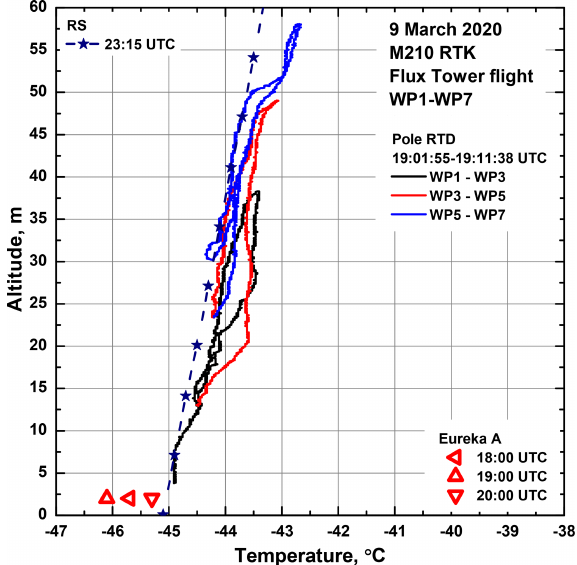
Figure 11. Temperature profiles measured during the M210 RTK flux tower flight along WP1–WP7 waypoints on 9 March 2020. Line colours represent individual profiles in the course of the flight (see Fig. 7 for the locations of the temperature